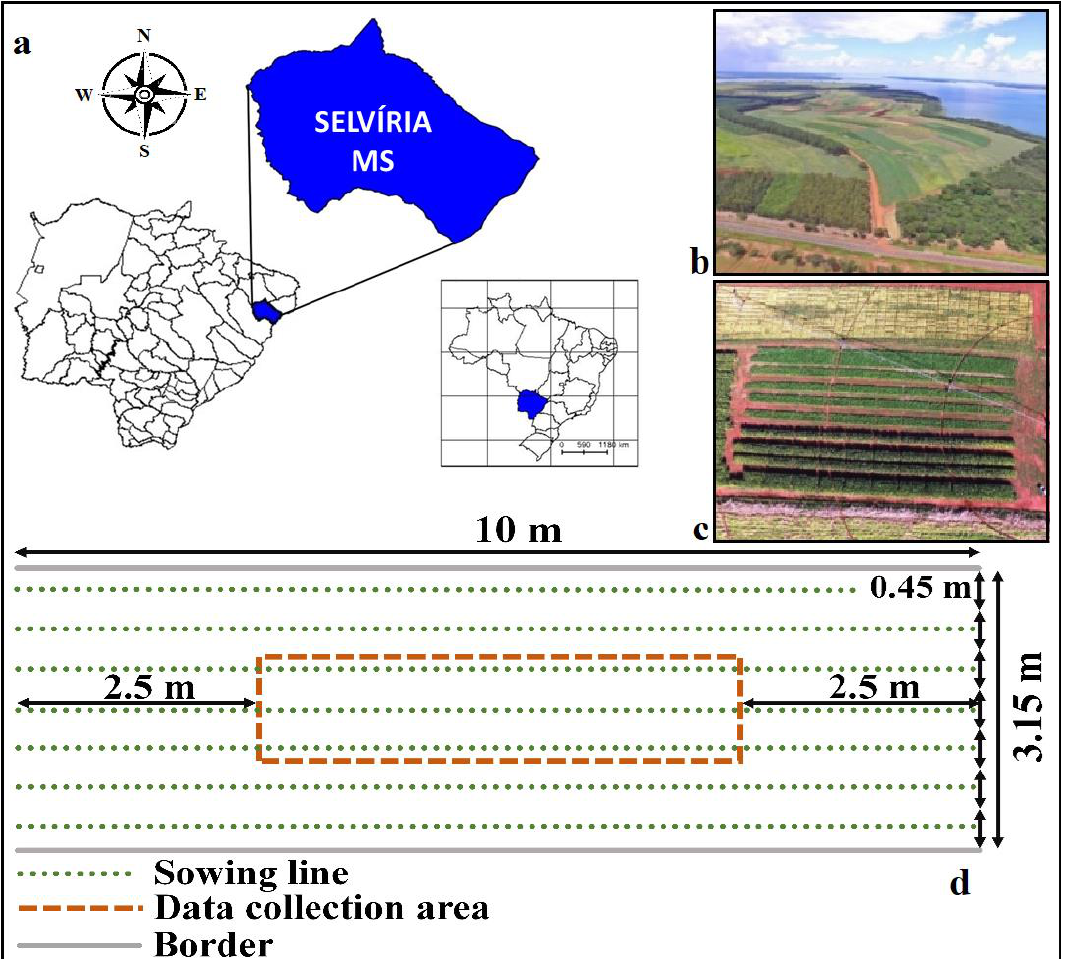
Figure 1. Experimental area at the Selvíria County ( a : 20°20 ′ 35 ″ S, 51° 24 ′ 04 ″ W; 358 m asl; Mato Grosso do Sul State — MS, Brazil); ( b ) aerial view of the entire experimental area and ( c ) randomized plots; ( d ) schematic representation of a single plot with the individuation of the “useful area” for soil and plant data collection.